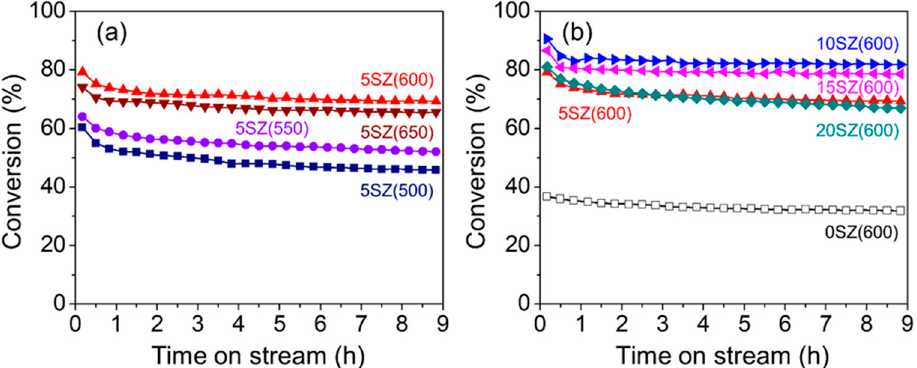
Figure 7. Formic acid conversion as a function of time on stream over ( a ) 5SZ( y ) and ( b ) x SZ(600) catalysts at 260 °C and 6.0 h − 1 WHSV.